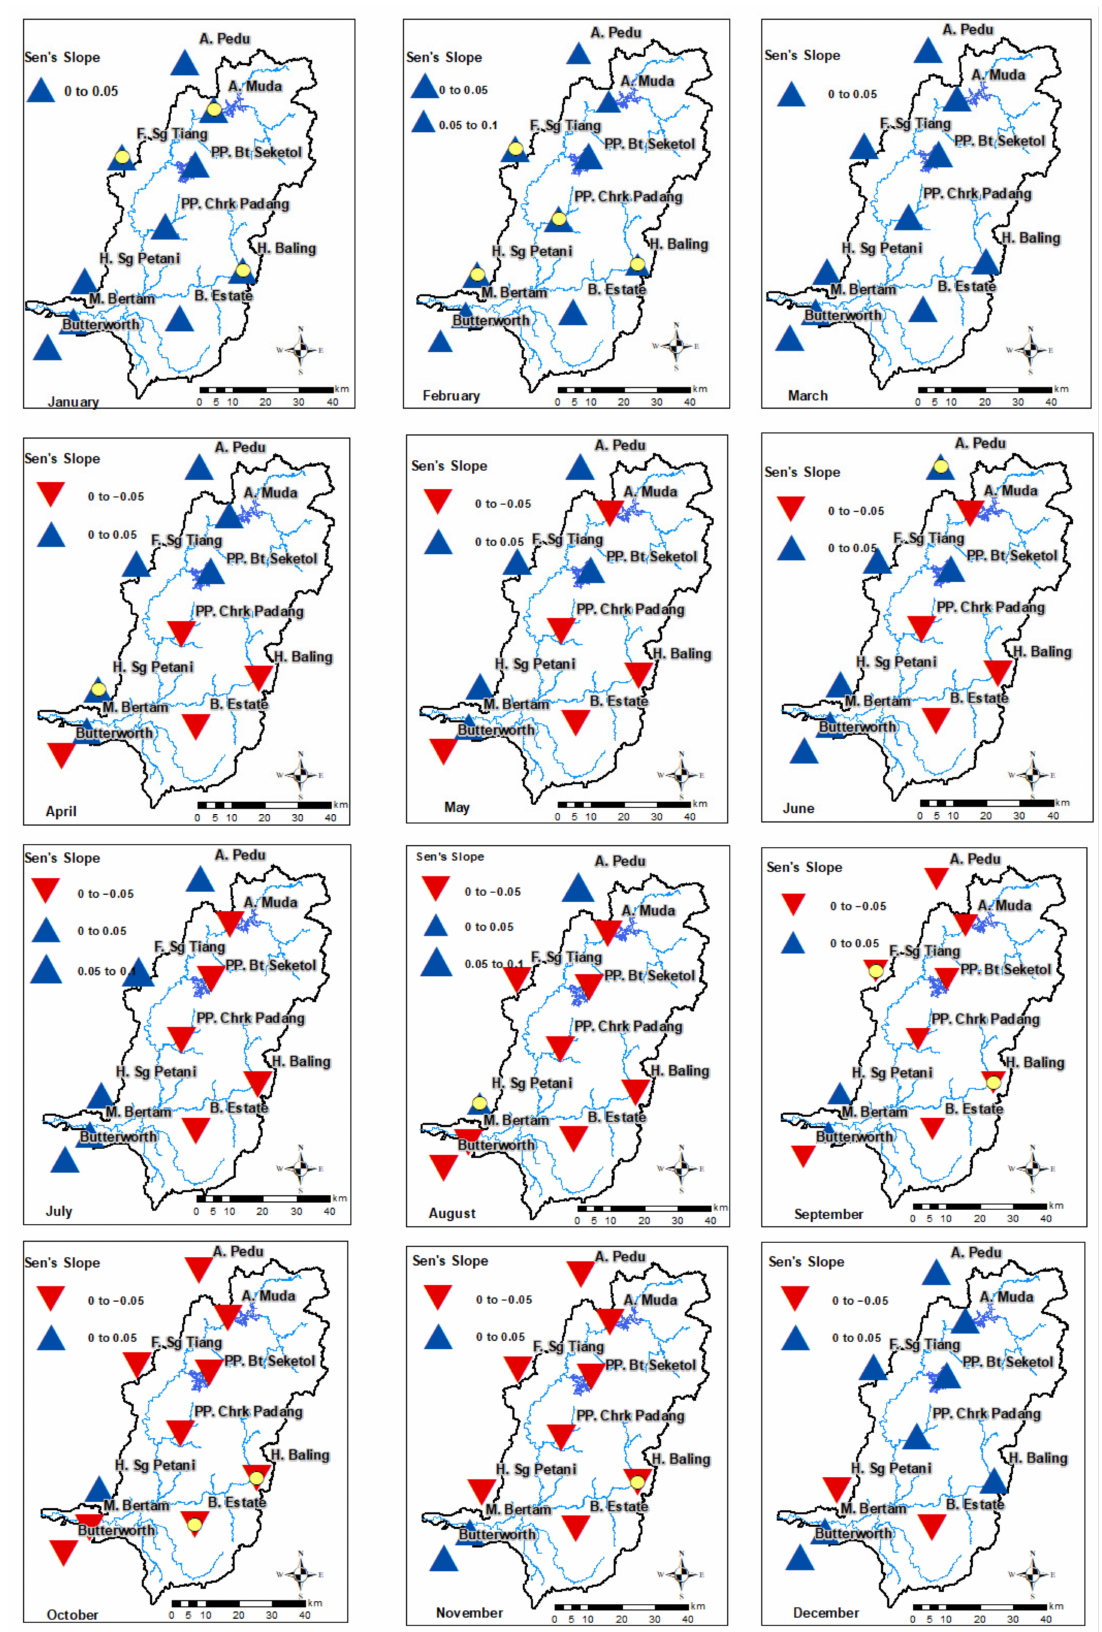
Figure 3. Spatial distribution of Sen’s slopes for months (dotted = significant trends, positive = increase, negative =